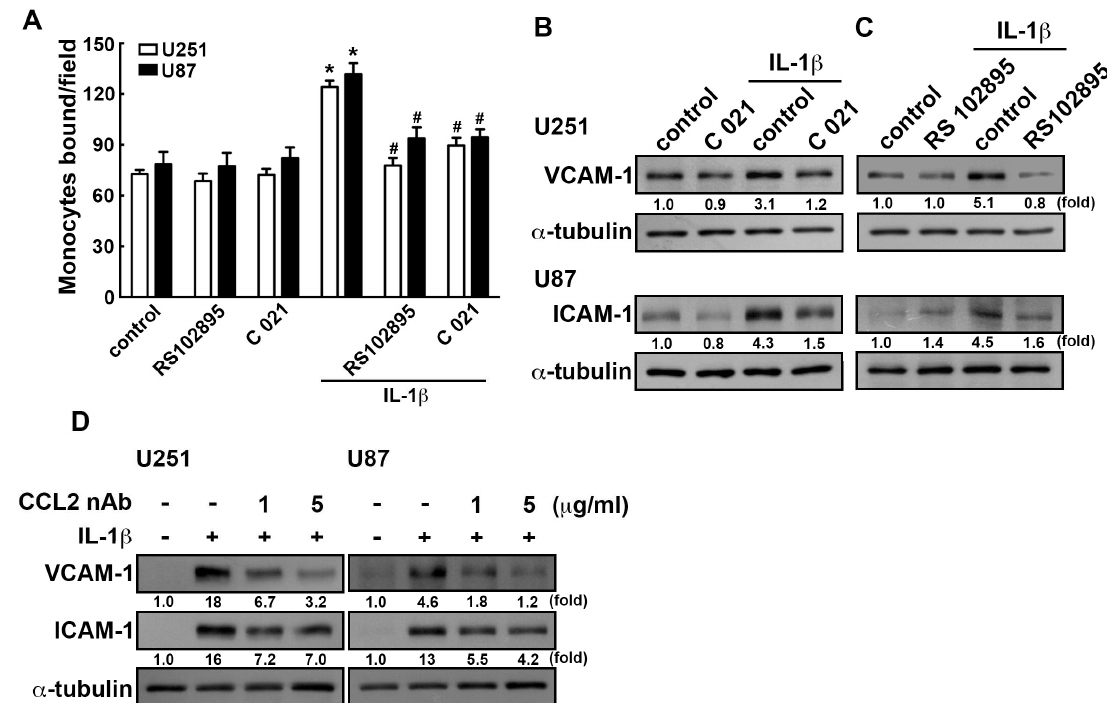
Figure 6. CCL2 involves in the IL-1 β -induced ICAM-1 and VCAM-1 in GBM. ( A ) U251 and U87 cells were pretreated with CCR2 antagonist RS102895 (400 nM) or CCR4 antagonist C 021 (400 nM) for 45 min and administrated with IL-1 β (3 ng / mL) for another 24 h. The binding activity of monocyte were analyzed by evaluating the BCECF-AM-labeled-THP-1 using the fluorescence microscopy. GBM cells were added with CCR4 antagonist C 021 (400 nM) ( B ) or CCR2 antagonist RS102895 (400 nM) ( C ) for 45 min and added with IL-1 β (3 ng / mL) for another 24 h. ICAM-1 and VCAM-1 expression was assessed by western blotting. ( D ) U251 and U87 cells were administrated with anti-CCL2 neutralizing antibodies (1 or 5 µ g / mL) for 45 min and added with IL-1 β (3 ng / mL) for another 24 h. The expression levels of ICAM-1 and VCAM-1 was assessed by western blotting. The values are presented as mean ± S.E.M. (representative of independent experiments = 3). * p < 0.05 compared with the control group, # p < 0.05 compared with the IL-1 β administration group. nAb, neutralizing antibody.